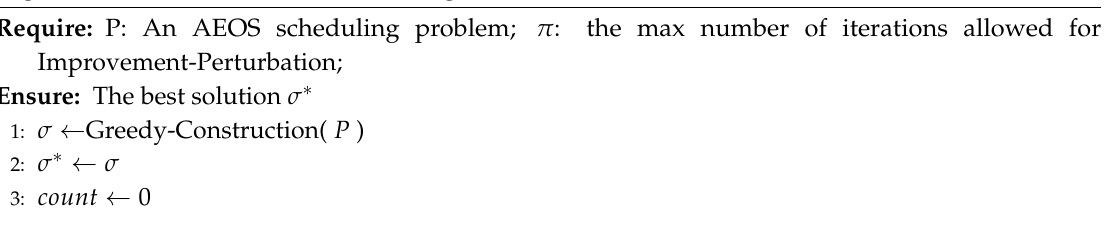
Algorithm 1. Main Procedure of Our